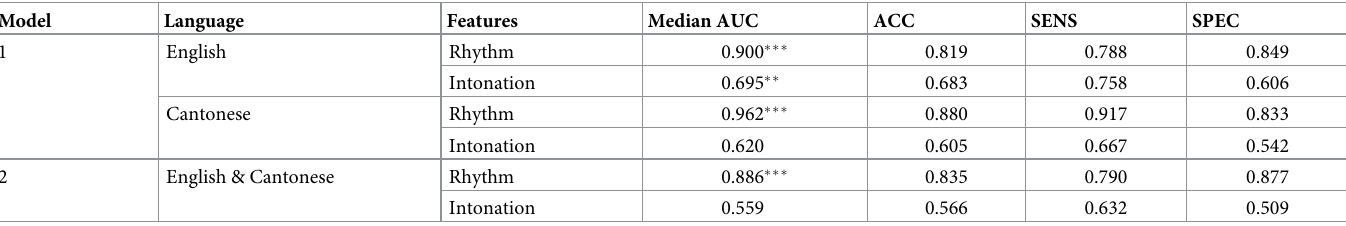
Table 2. Model statistics.